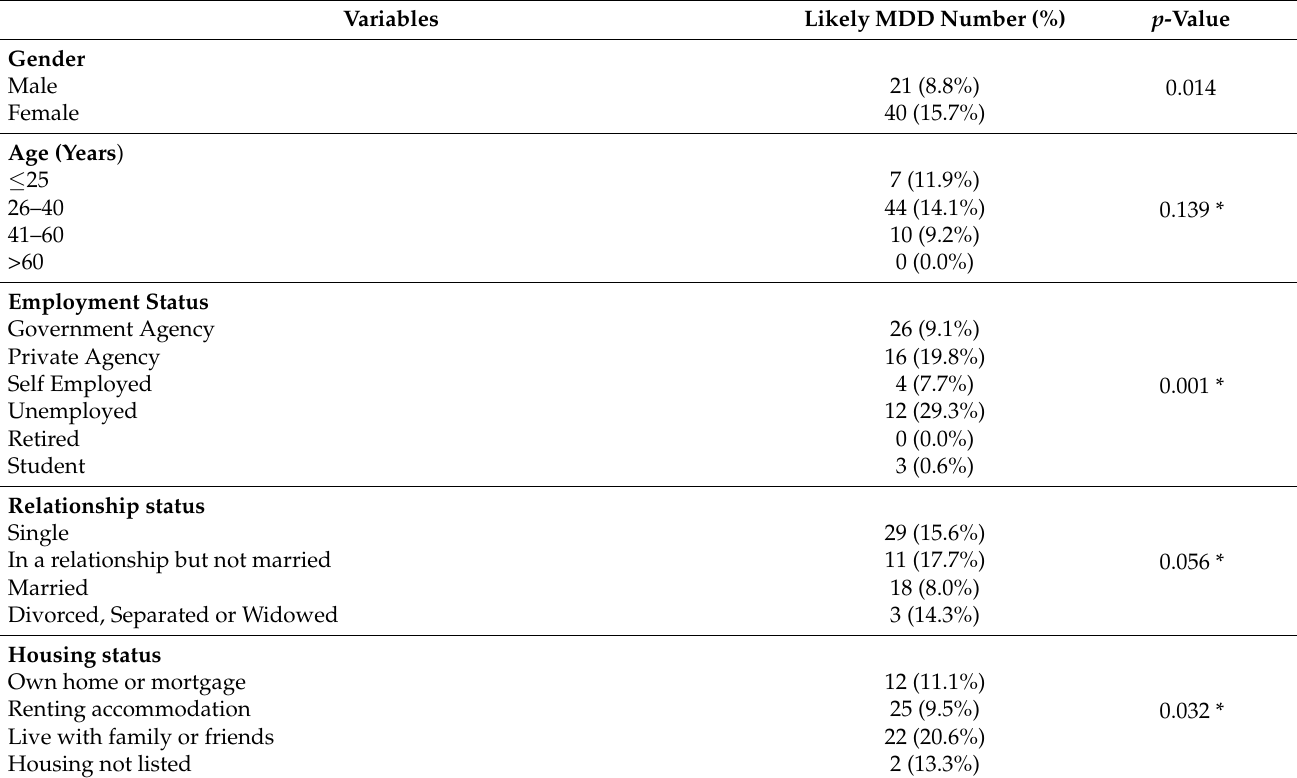
Table 3. Chi-squared and Fisher’s exact test, * test of association between the demographic, social and clinical antecedents and likely